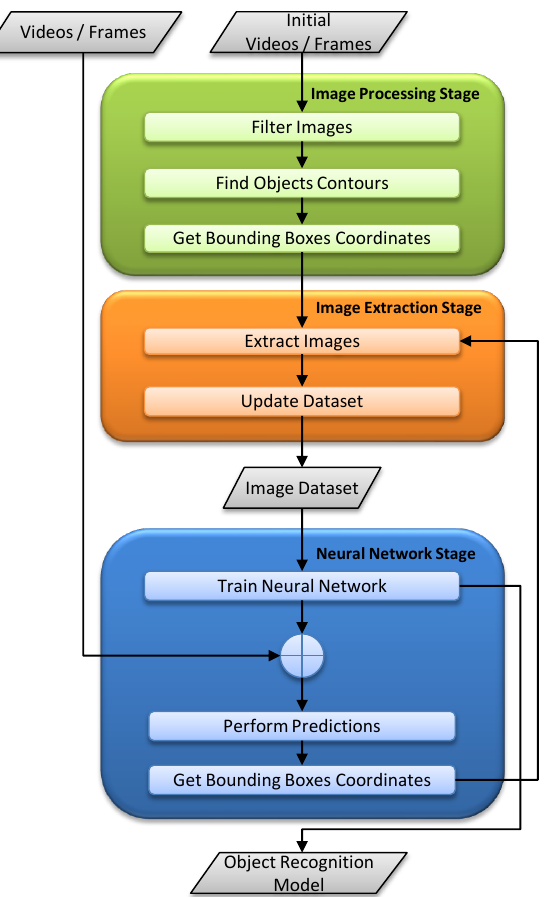
Figure 1: Flow diagram of the top level view techniques of image processing to enhance and isolate objects of interest in environments where objects are easily separable from the background, such as fish un- derwater. The output of this stage is a set of bounding boxes coordinates enclosing the isolated objects. The details are explained in section